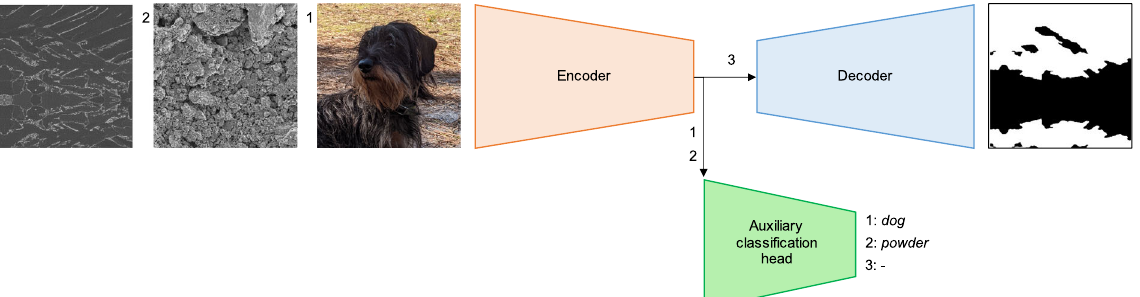
Fig. 6 Summary of the pre-training and fi ne-tuning procedure. Starting from ImageNet pre-trained weights (1), we optionally use the NanoSEM dataset 37 for pre-training the encoder of the model on this classi fi cation task (2). The weights of the encoder are then directly transfered for the fi nal fi ne-tuning on the source domain (3), while the decoder is